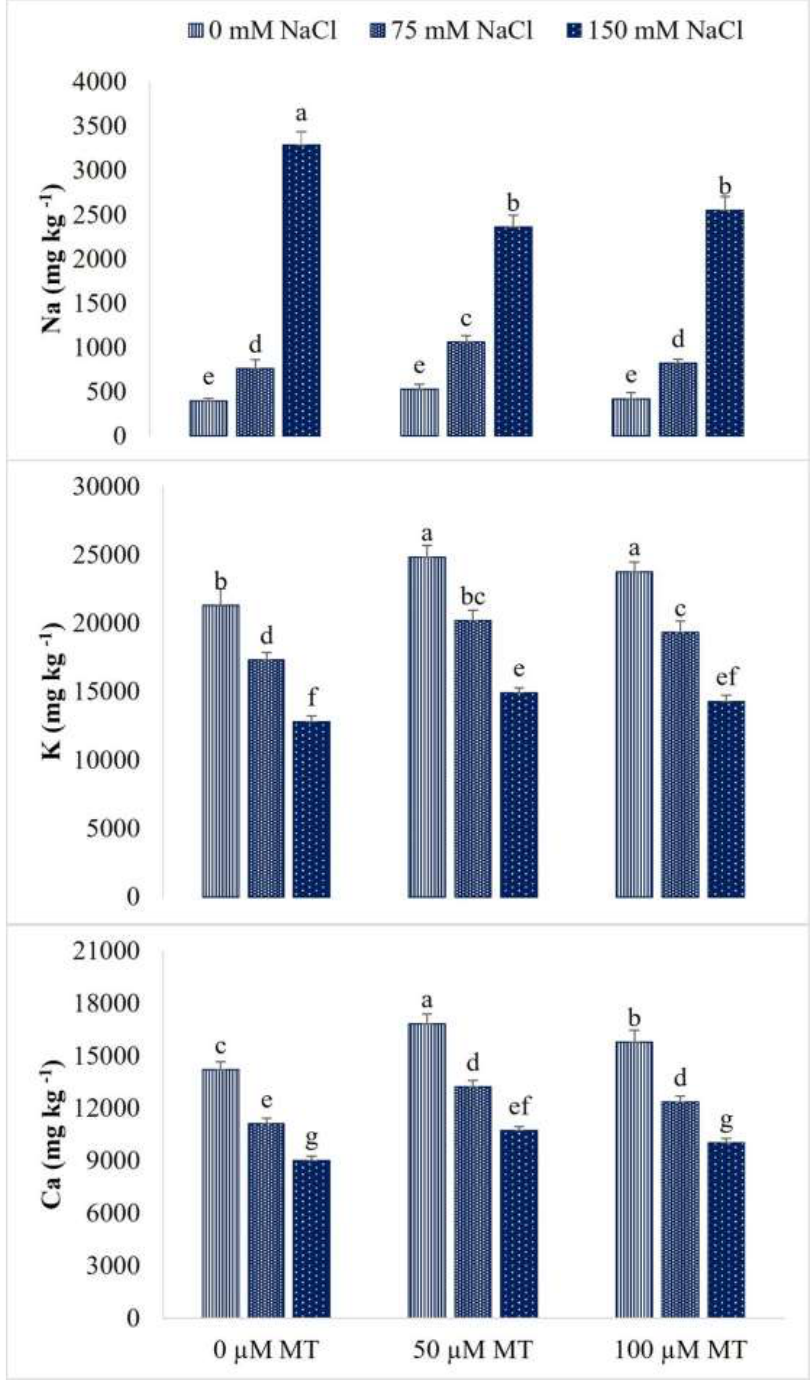
Figure 3. K, Na, and Ca content response in the leaves of the chickpea seedlings under salinity stress to MT